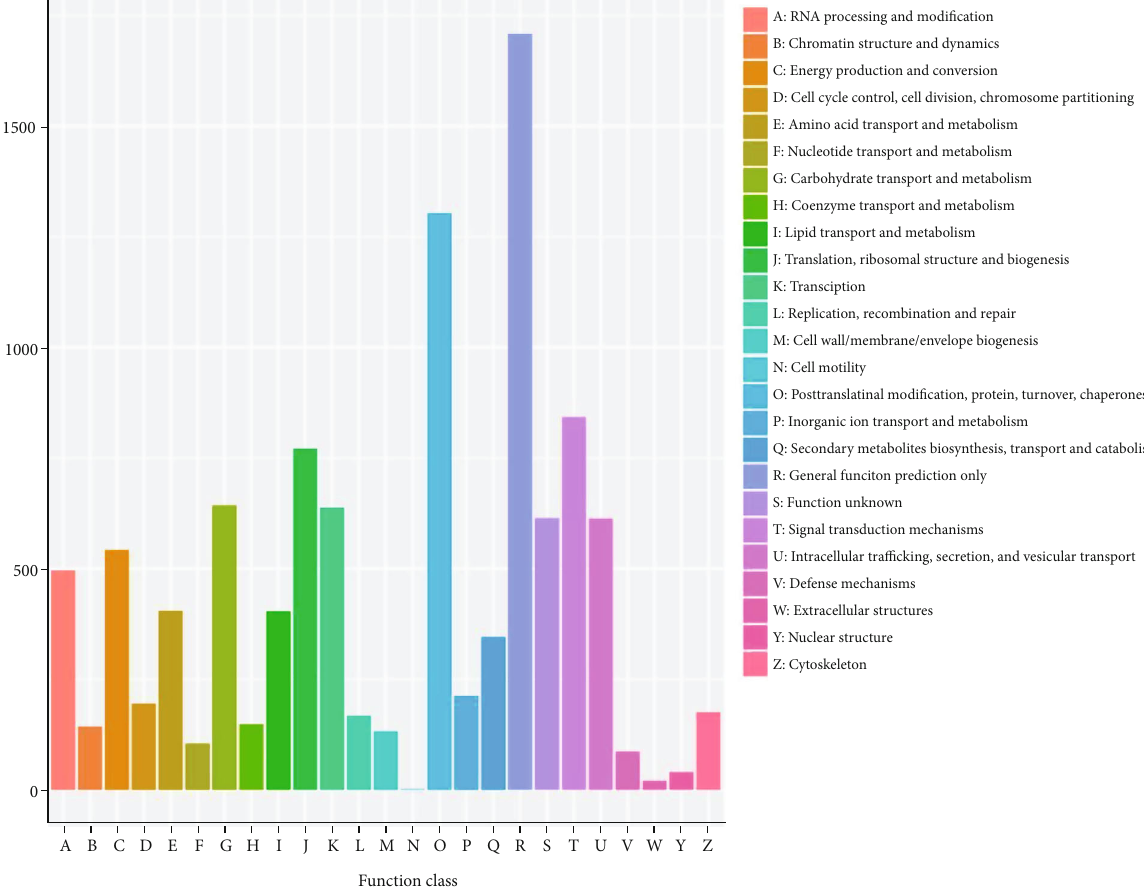
Figure 8: The KOG classi fi cation of tiger lily transcripts. The x -axis and y -axis represent the subcategories and the number of transcripts,